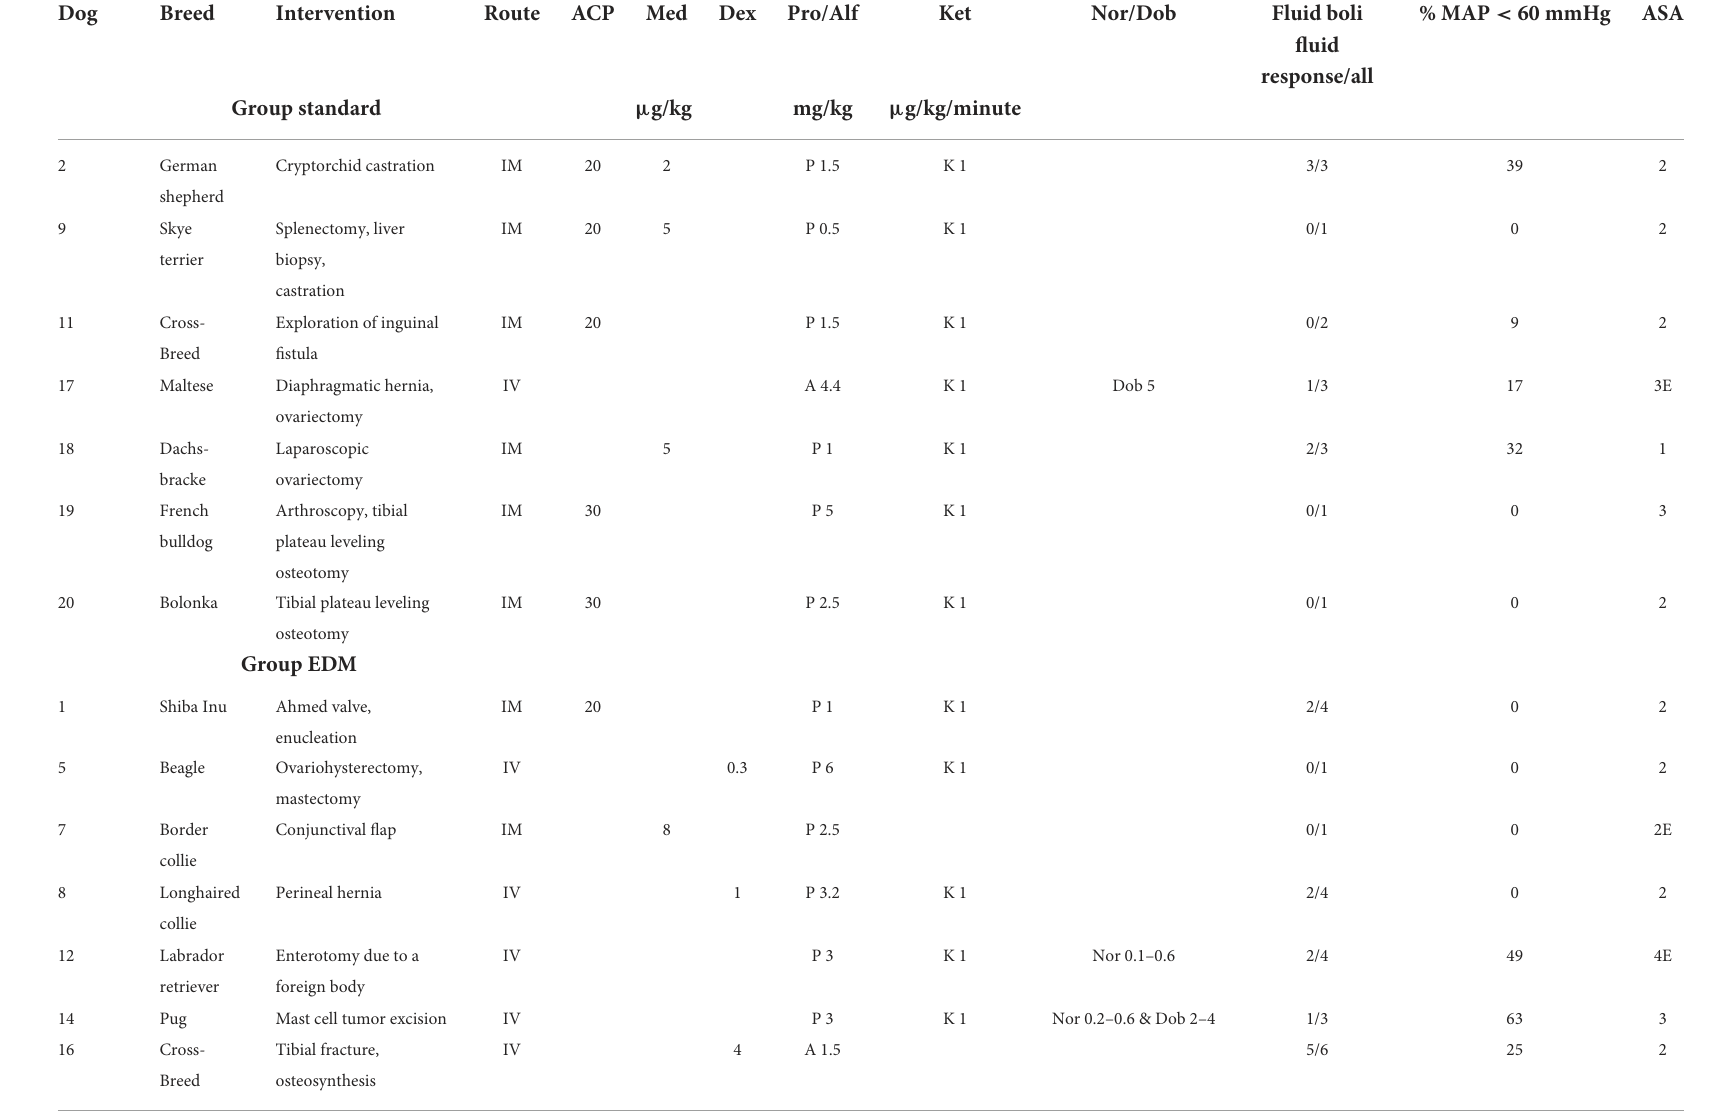
TABLE 2 Individual description of 14 clinical canine patients receiving intraoperative fluid therapy based on two different treatment algorithms.